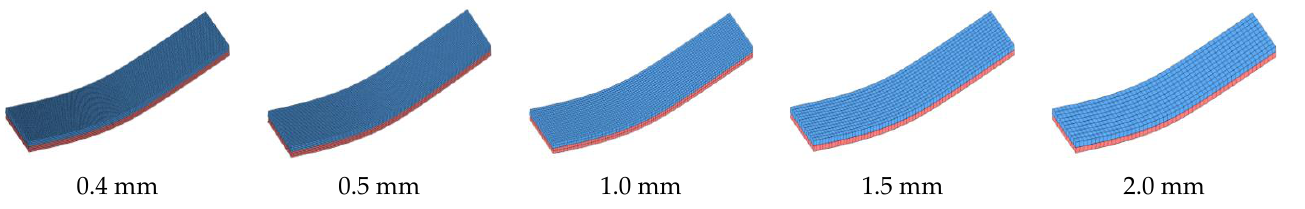
7 of 16 Figure 6. Model I delamination failure based on the tiebreak contact algorithm correction. ( a ) Un- corrected load – displacement curve; ( b ) corrected load – displacement curve. It can be seen that the different mesh densities that could be obtained after the con- version of interlayer strength could be very approximate. However, with increases in